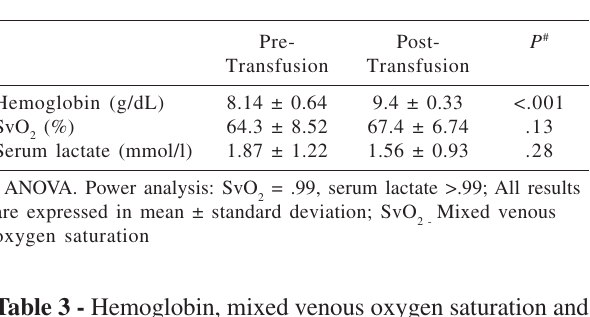
Table 3 - Hemoglobin, mixed venous oxygen saturation and serum lactate pre- and post-transfusion in the subgroup with hemoglobin between 8-9 g/dL Pre-